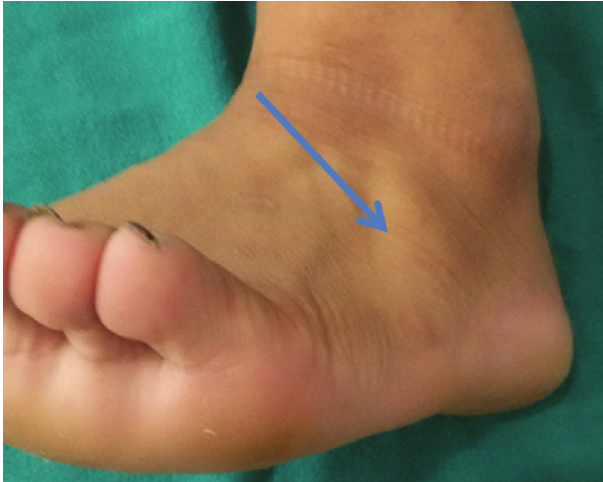
Figure 2. Normal EDB (arrow head) in a healthy volunteer.